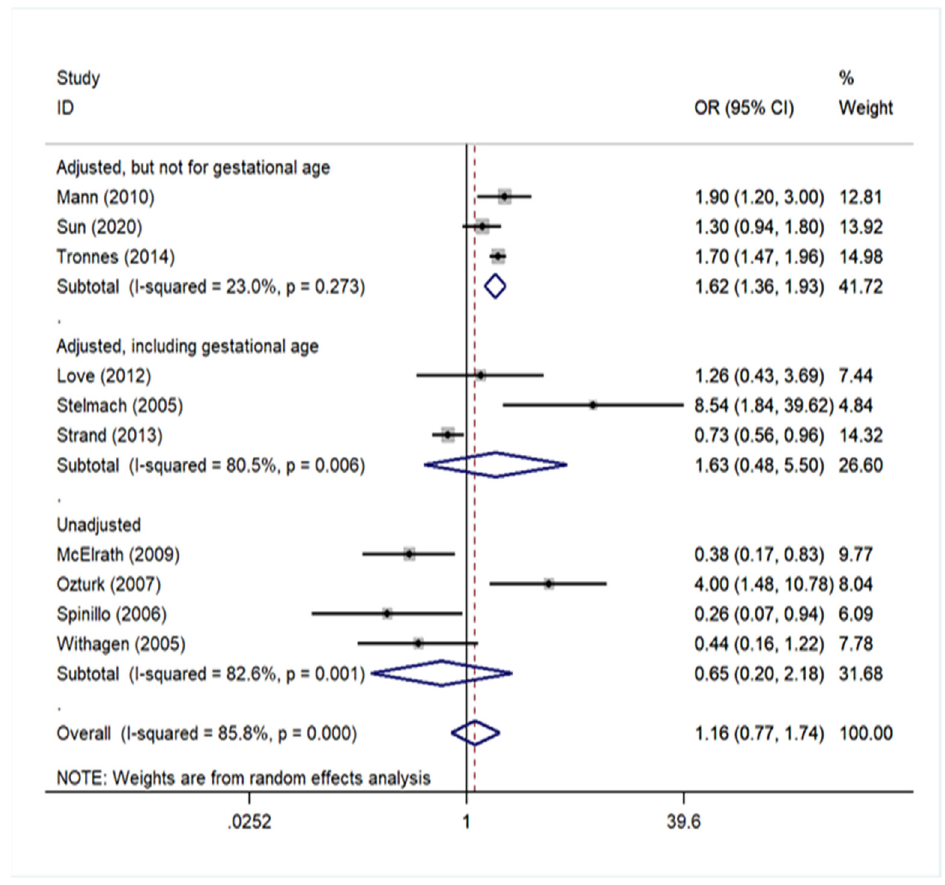
Figure 1. Forest plot describing the association between preeclampsia and cerebral palsy and the subgroup analysis by degree of adjustment. subgroup analysis by degree of